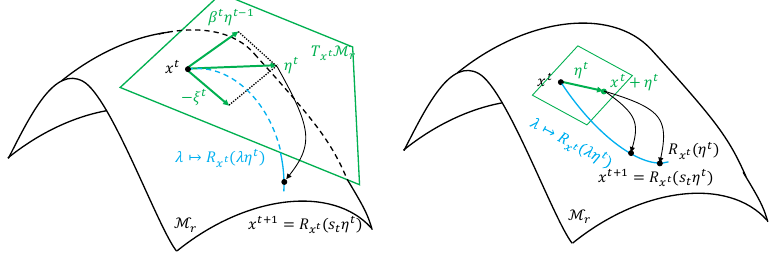
Figure 1. Illustration of the tangent space, the conjugate direction, and the retraction